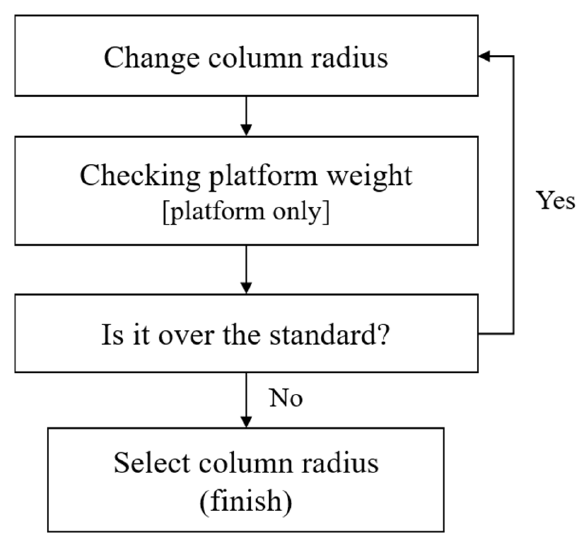
Figure 9. Column radius selection procedure.